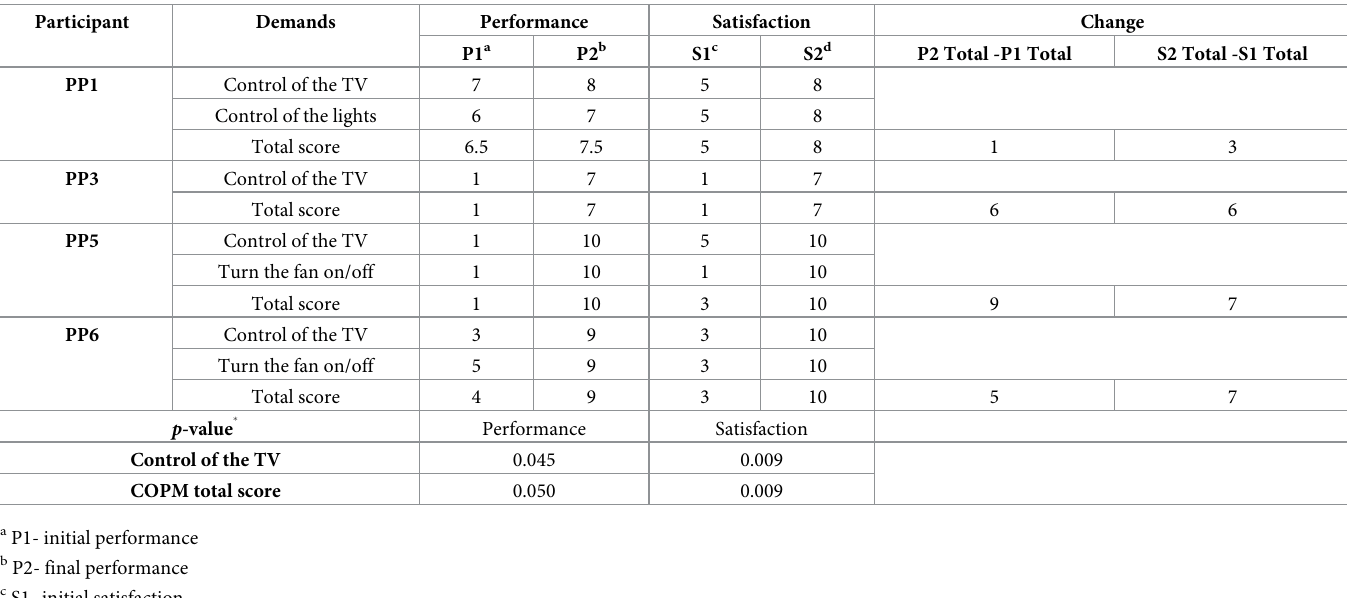
Table 3. COPM and Paired Sample t -Test results of participants who used the